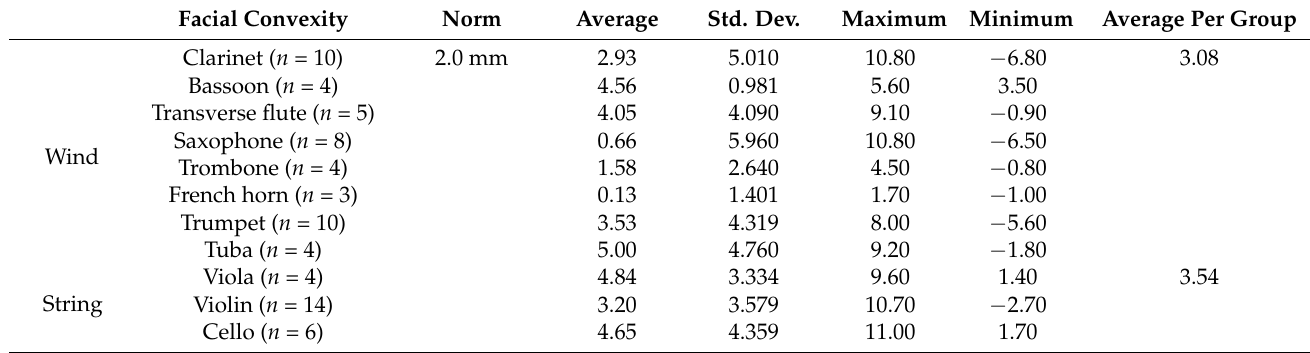
Table 5. Descriptive statistics for the variable facial convexity.